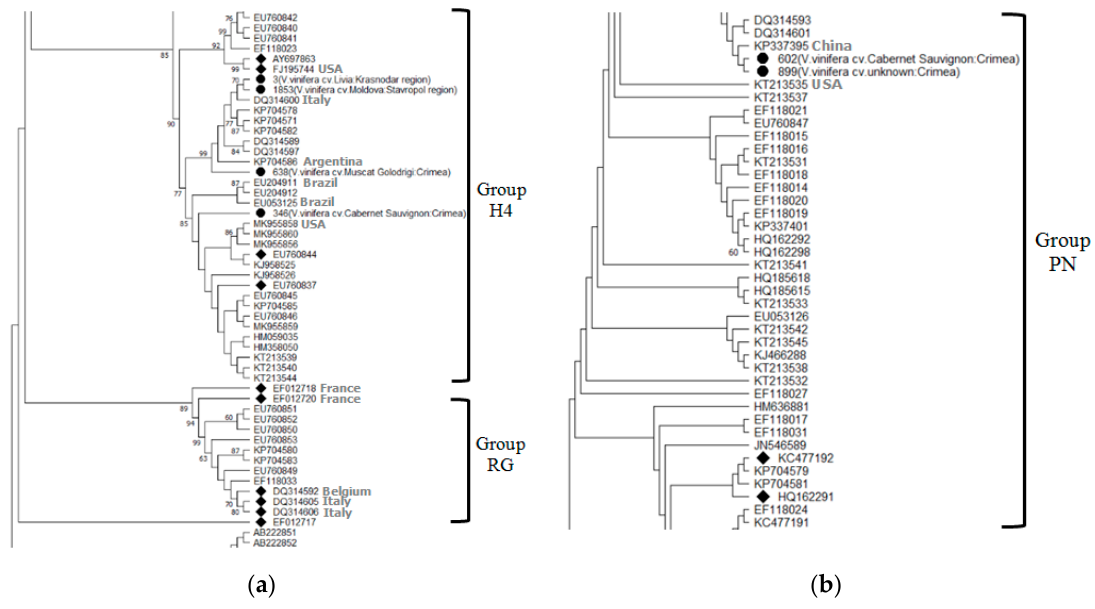
Figure 4. Phylogenetic tree showing the distribution of nucleotide sequences of coat protein genes in Russian isolates of Grapevine leafroll-associated virus 2 ( a , b ) (•) compared to isolates from the GenBank and representative sequences ( ). Geographic origin is indicated for each Russian isolate (in brackets). Bootstrap values > 60% (1000 bootstrap replicates) are shown.